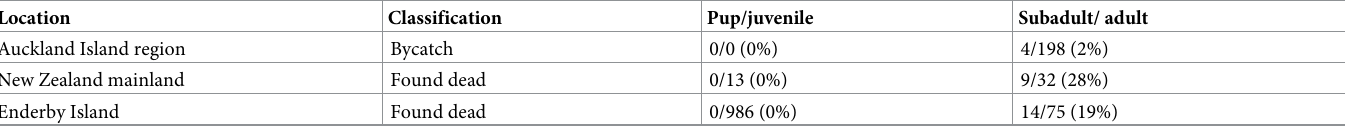
Table 2. Provenance and age group details for New Zealand sea lions.